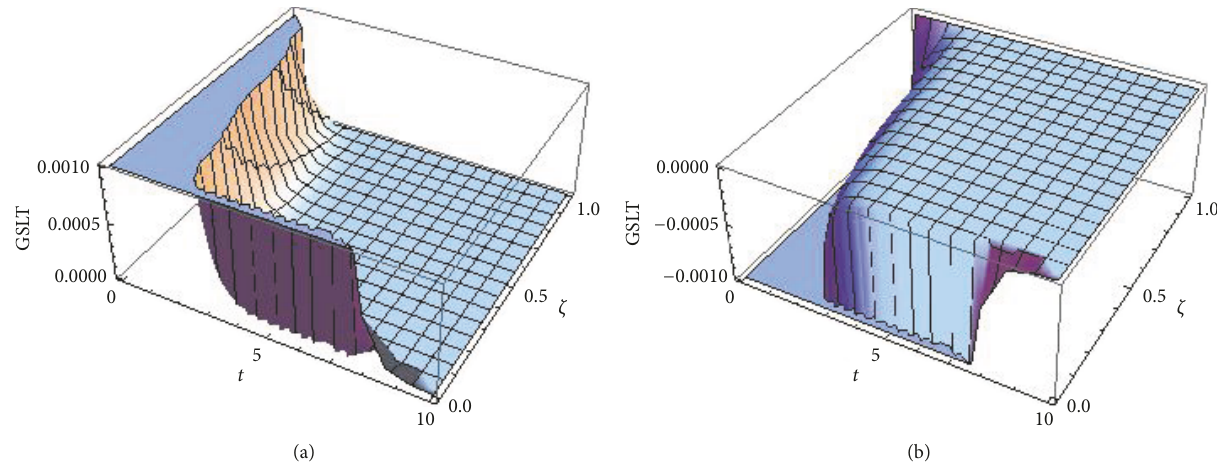
Figure 1: Validity of GSLT for the model (44). (a) is for 𝑐 1 = 𝑐 2 = 1 and (b) for 𝑐 1 = 1 with 𝑐 2 = −1 .